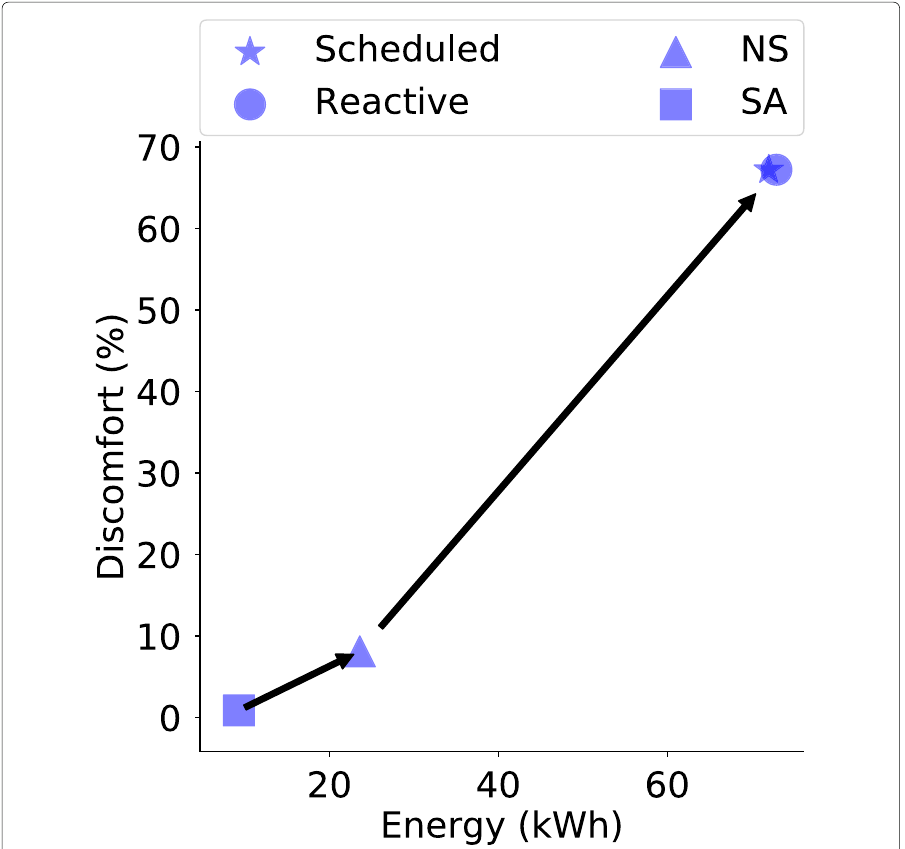
Fig. 8 Summers. Energy-discomfort plot when prediction is perfect. The arrow indicates the performance degradation, in terms of energy consumption and user comfort, when we move from predictive to non-predictive control